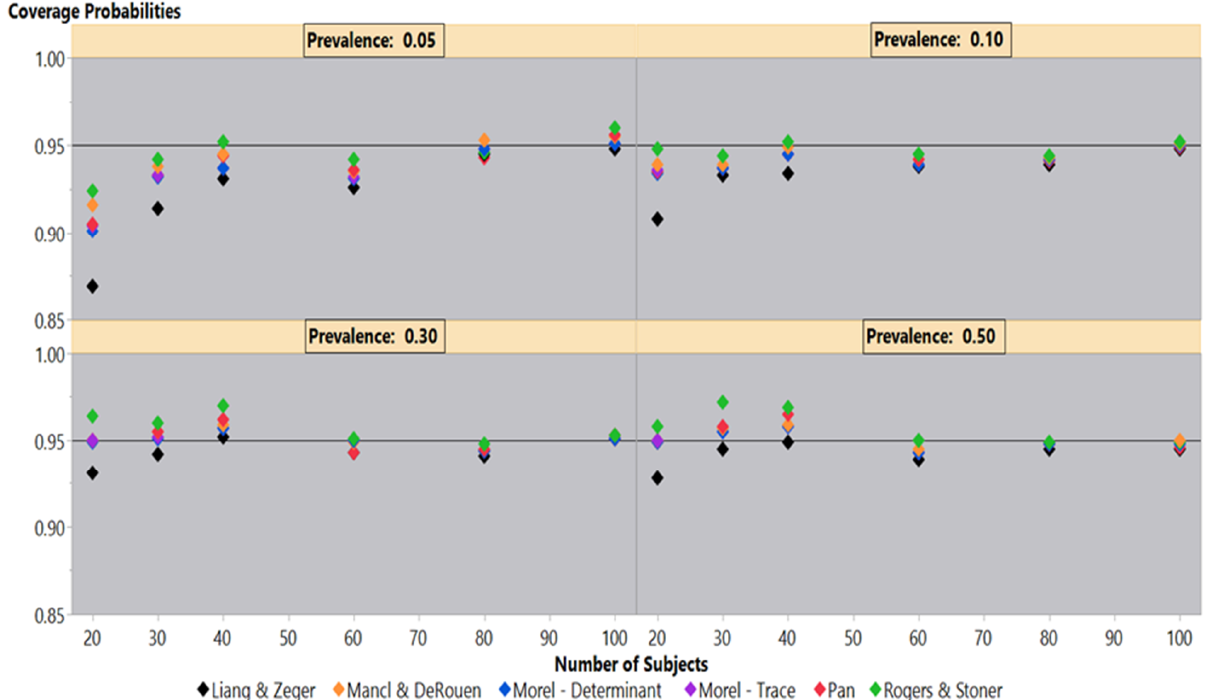
 under a simulated independence 1